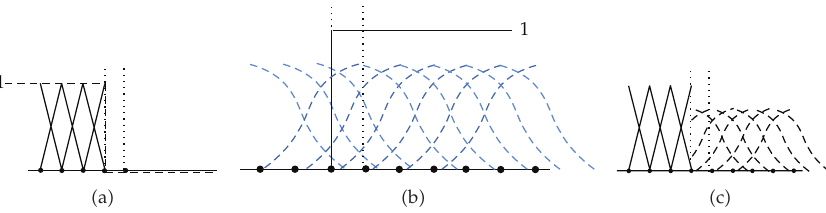
Figure 2: Combination of shape functions in an interfacial area of FEM and FMLSRKM. (cid:2) a (cid:3) Shape functions of FEM, (cid:2) b (cid:3) shape functions of FMLSRKM, and (cid:2) c (cid:3) shape functions of hybrid method. Shape function of FMLSRKM is fully adopted as shape function of the interfacial area (cid:2) inside two vertical dotted lines (cid:3)